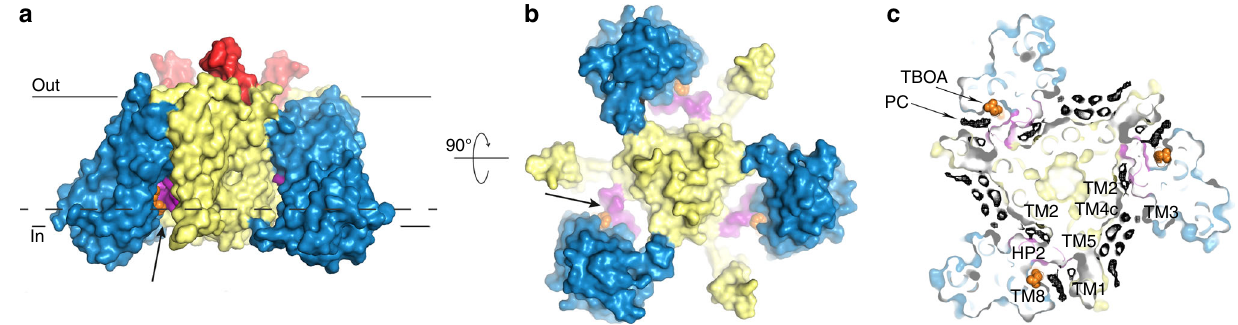
Fig. 4 Accessibility of the substrate-binding site and lipid densities. a , b Surface representation of the ASCT2 C467R structure in presence of TBOA, with the transport domain in blue, the scaffold in yellow, the antennae in red, the HP2 loop in purple and TBOA in orange. The open HP2 gate provides access to the binding site from the cytoplasm (indicated by arrows). c Slice through the surface representation of ASCT2 C467R (level is indicated by dashed line in panel a ) with putative lipid densities surrounding the scaffold domain shown in black and TBOA as orange balls (see also Supplementary